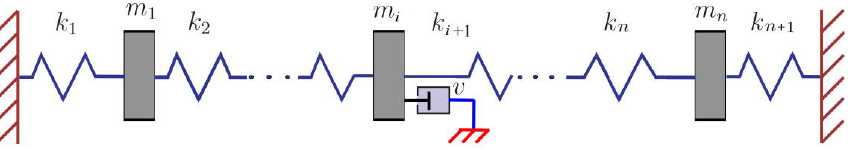
Figure 1. The n -mass oscillator with one